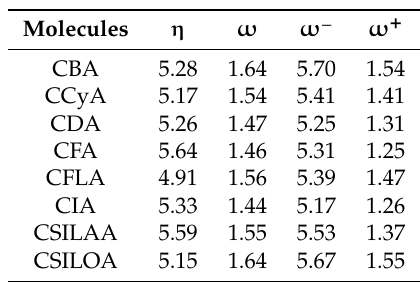
Table 3. Chemical reactivity parameters of carbazole-based dyes (in eV) obtained by density functional theory (DFT) conceptual at M06 / 6-31G(d) level of